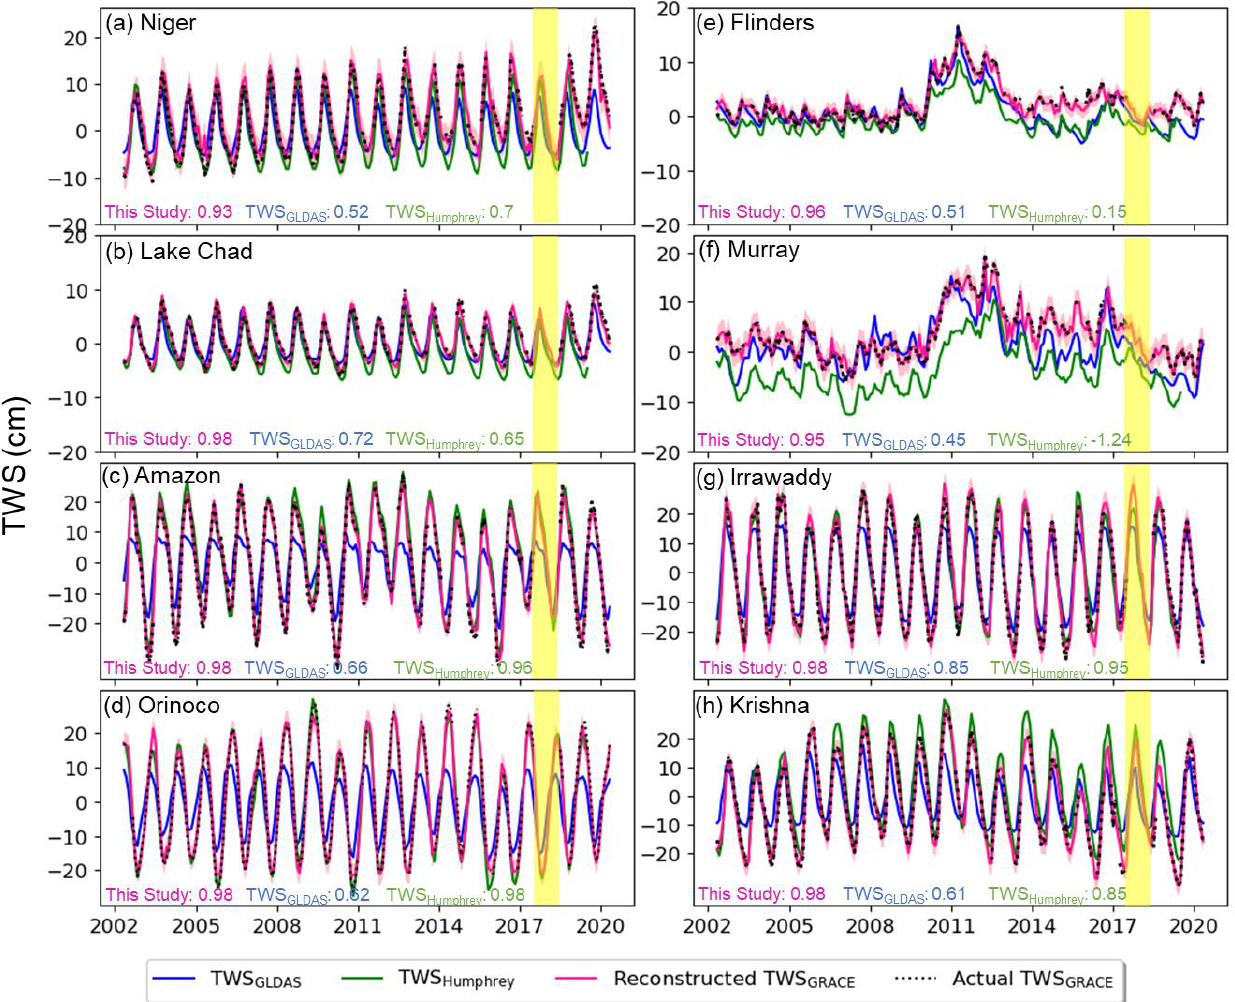
Figure 10. Reconstructed TWS GRACE results for eight representative basins: ( a ) Niger, ( b ) Lake Chad, ( c ) Amazon, ( d ) Orinoco, ( e ) Flinders, ( f ) Murray, ( g ) Irrawaddy, and ( h ) Krishna. The actual TWS GRACE , reconstructed TWS GRACE , TWS GLDAS , and Humphrey and Gudmundsson (2019)-derived TWS (TWS Humphrey ) time series are indicated by black dots, pink line, blue line, and green lines, respectively. The root-mean-square error for the testing set is plotted as error bar (pink shading) for the reconstructed TWS GRACE . The vertical yellow rectangle shows the gap period between the GRACE and GRACE-FO missions. The NSE between the actual TWS GRACE and reconstructed TWS GRACE , the actual TWS GRACE and TWS GLDAS , and actual TWS GRACE and TWS Humphrey are shown at the bottom of each subplot in pink, blue, and green text,